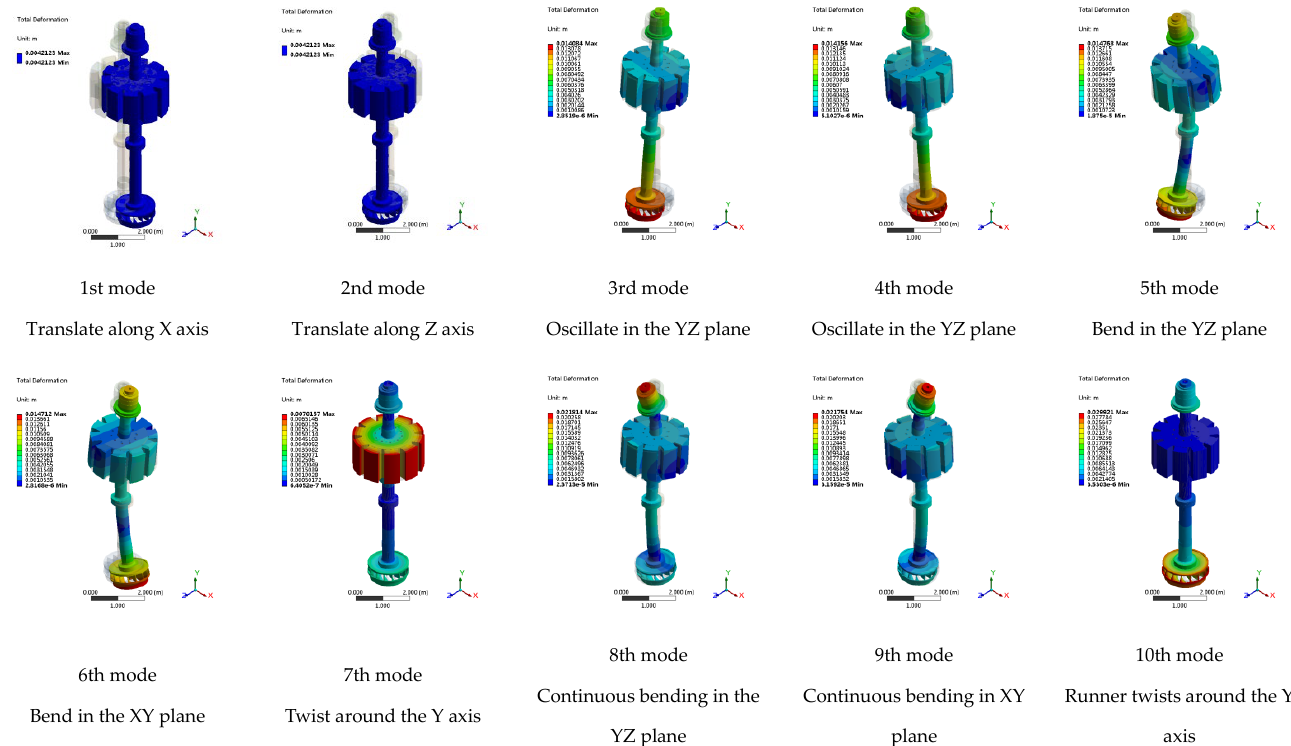
Figure 4. Modal shapes of the first ten order modes.